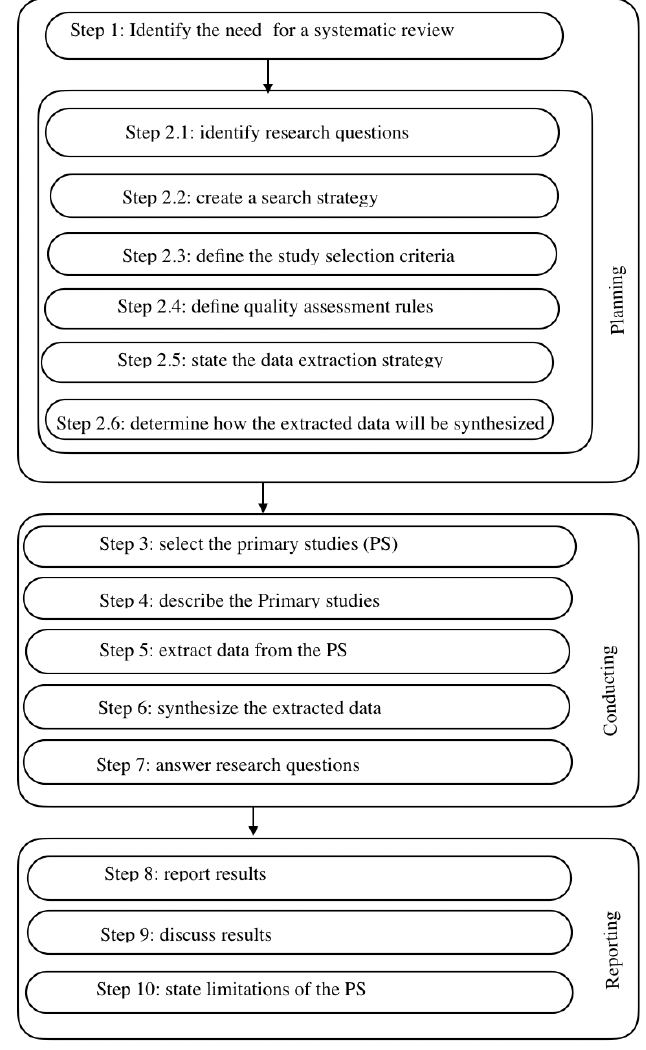
Figure 5. Systematic review